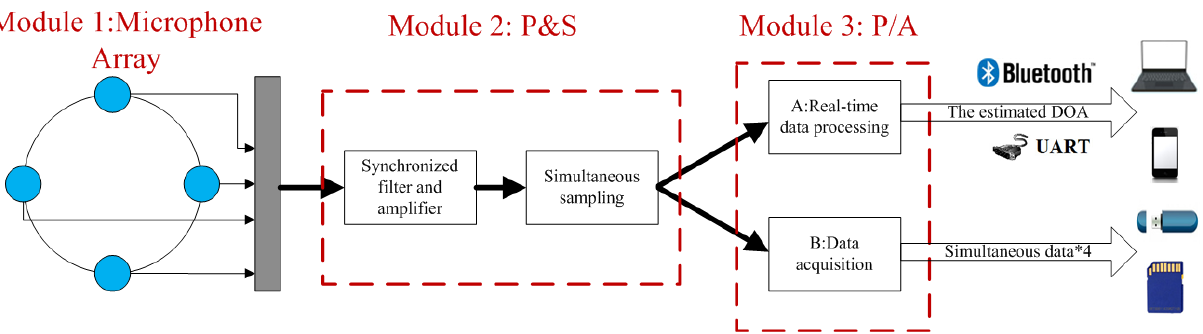
Figure 2. Block diagram of the MEMS microphone array